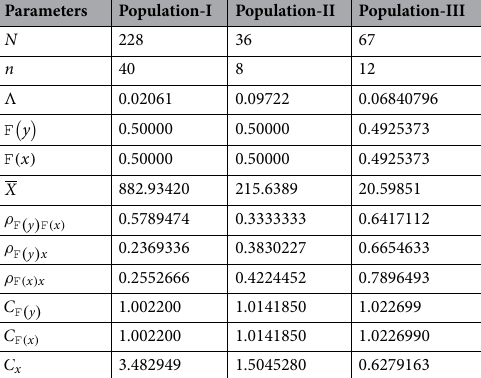
Table 1. Summary statistics using real data